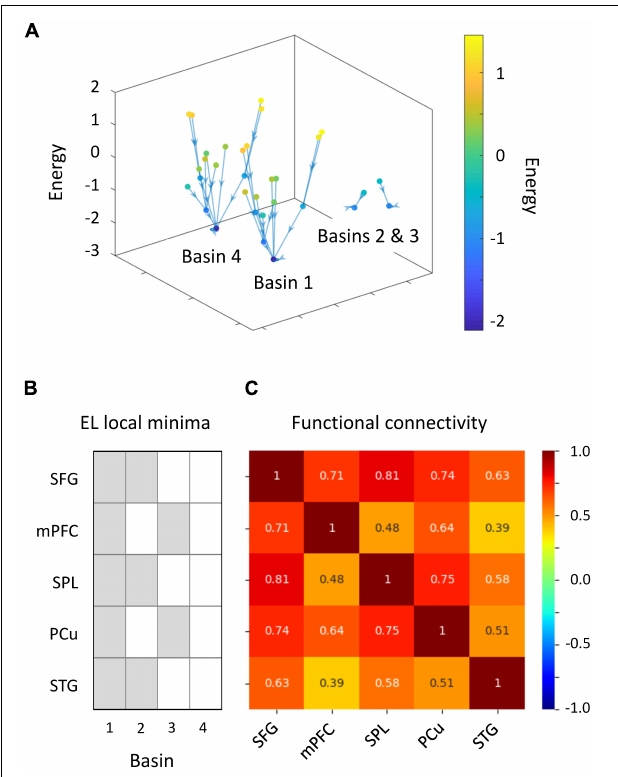
FIGURE 4 | Results of energy landscape (EL) analysis. (A) Constructed EL. BOLD signals obtained from five regions of interests (ROIs) were binarized. Activity patterns were computed using the appearance probability of binarized states and categorized into four basins in EL. (B) ROI classification based on the disconnectivity graph. The EL transition rate was derived from activity patterns of active and inactive ROIs. (C) Comparison of EL local minima and functional connectivity.